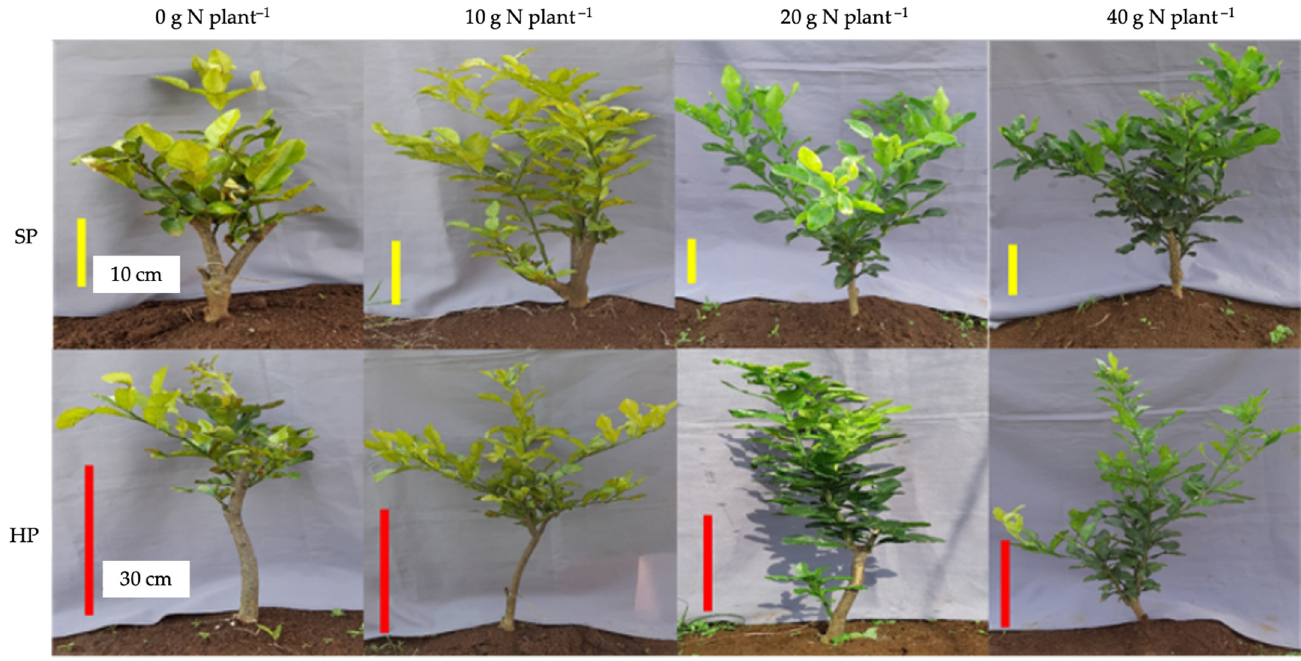
Figure 4. Kaffir lime appearance under different pruning levels and nitrogen-fertilizer dosages.